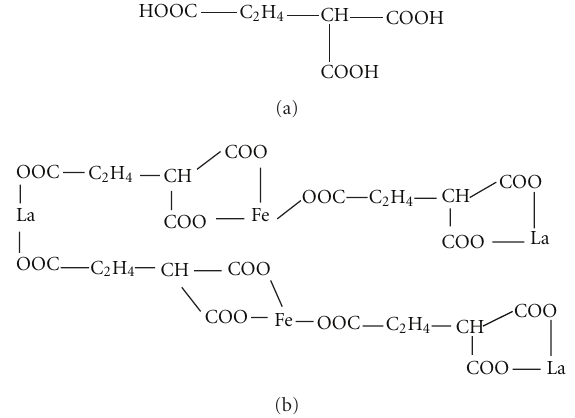
Figure 3: Molecular structure for the citric acid (a) and for a possible complex of metal ions and citric acid (b) in gel precursor of LaFeO 3 nanoparticles.